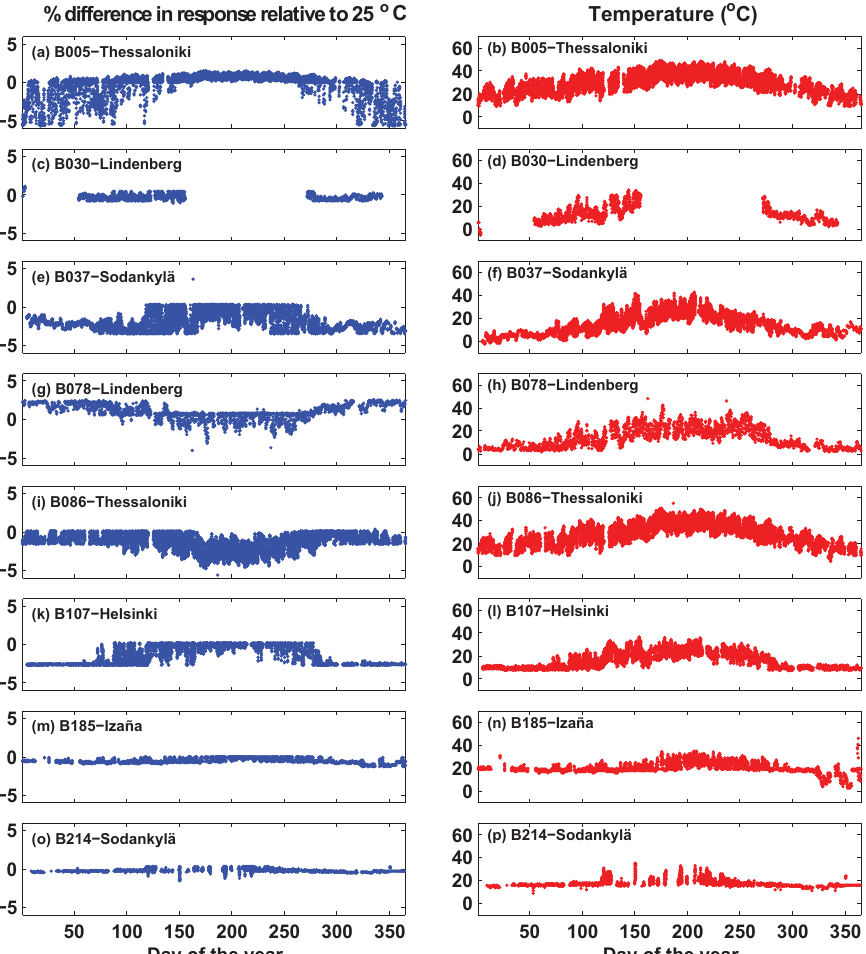
Figure 7. Differences (%) in the 315nm response from its value at 25 ◦ C due to the effect of temperature and the corresponding